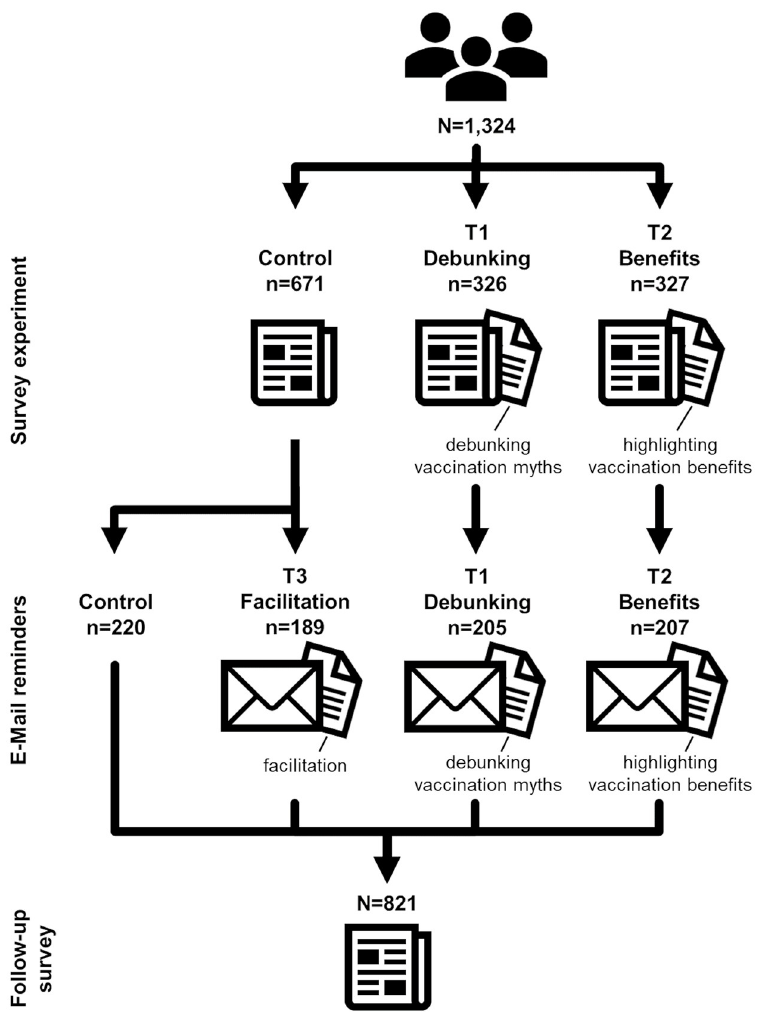
Fig 1. Study design & treatment groups. The three study phases are presented in rows, the treatment conditions in columns, and the n refers to the number of observations in each phase and treatment group. In the survey experiment, participants were randomly assigned to one of three groups: control, debunking (T1), or benefits (T2). Half of the participants in the control group were then randomly assigned to receiving facilitation emails (T3). Of the 1,324 participants from the survey experiment, 821 (62%) returned the follow-up